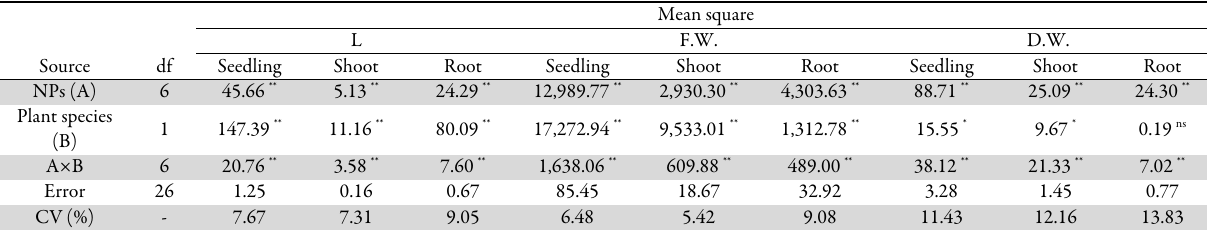
Table 6. Analysis of variance for some growth parameters of barley and wheat Mean square L F.W.